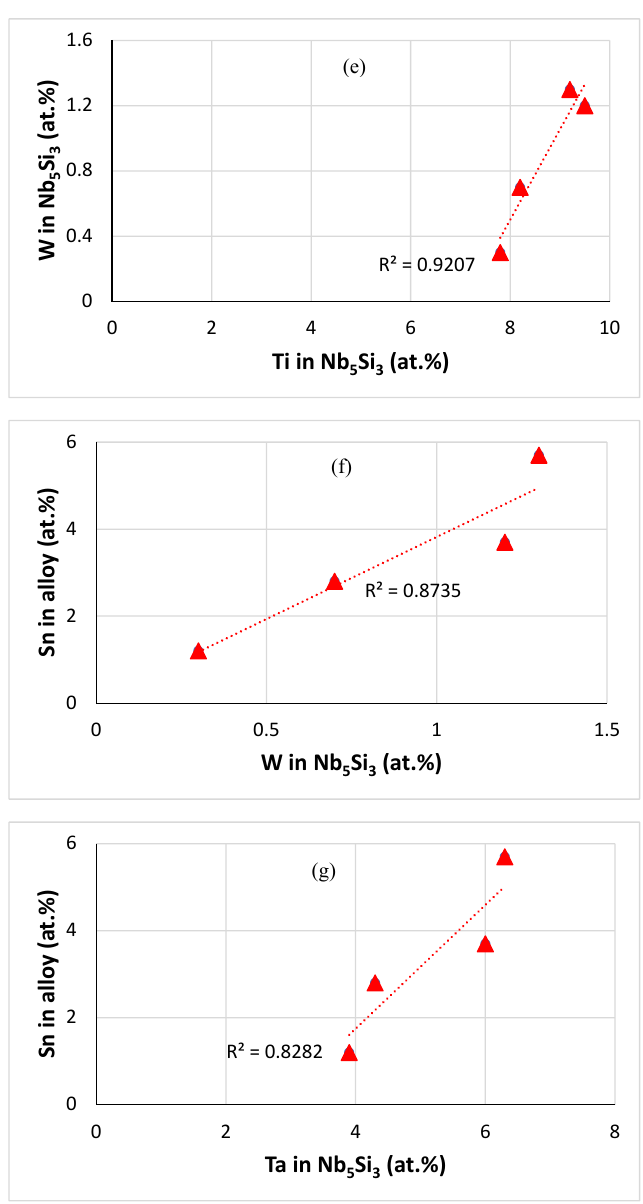
Figure 13. ( a ) Sn in Nb 5 Si 3 versus Ti in Nb 5 Si 3 , ( b ) Sn in the alloy versus Ti in Nb 5 Si 3 , ( c ) Sn in alloy versus Sn in Nb 5 Si 3 , ( d ) Ge in alloy versus Ge in Nb 5 Si 3 , ( e ) W in Nb 5 Si 3 versus Ti in Nb 5 Si 3 , ( f ) Sn in the alloy versus W in Nb 5 Si 3 , ( g ) Sn in the alloy versus Ta in Nb 5 Si 3 , blue squares for Ti-rich Nb 5 Si 3 , red triangles for normal Nb 5 Si 3 . In ( d ) R 2 = 0.8514 and R 2 = 0.9204 for linear fit, respectively of all